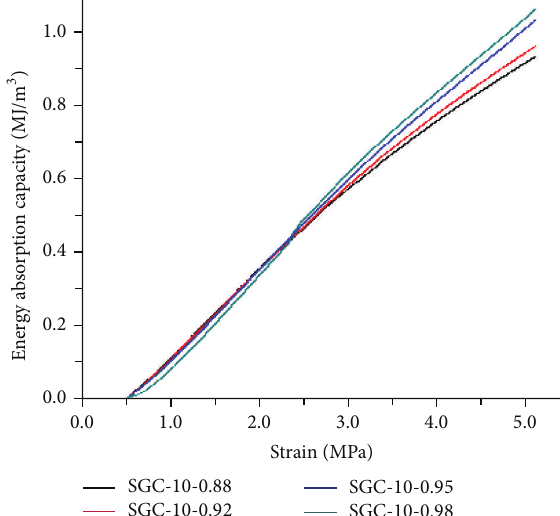
Figure 12: Energy absorption capacity of the WTDCEs.